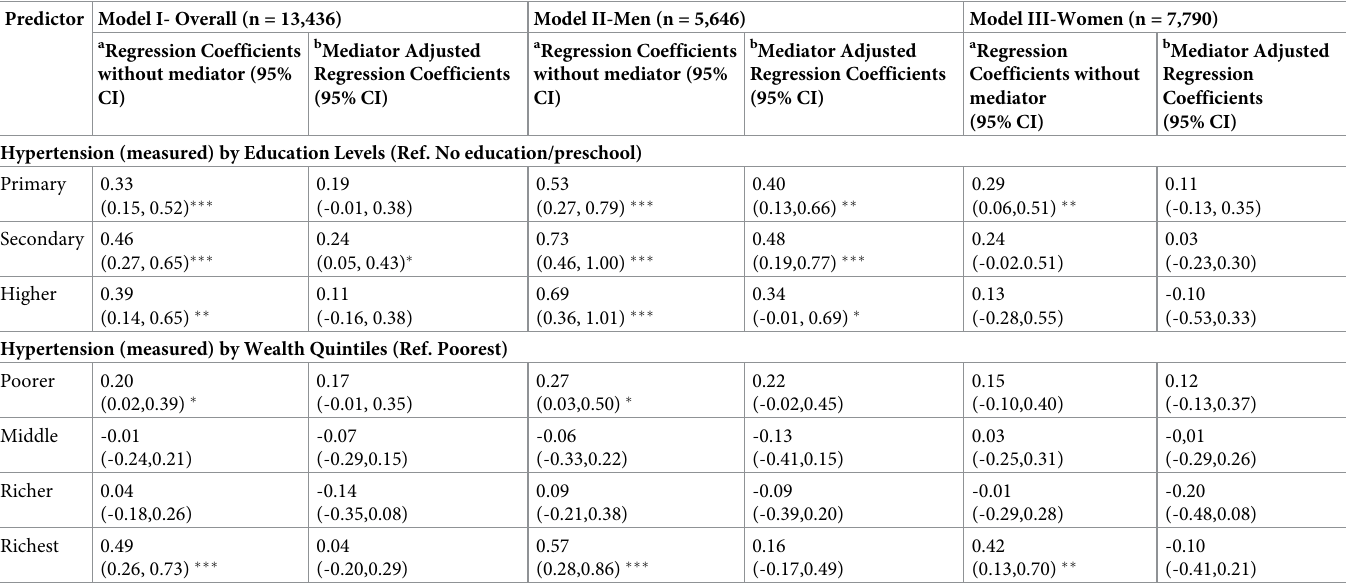
aCoefficients adjusted for age, sex, marital status, urbanity, and second-hand smoking; bCoefficients further adjusted for mediator-BMI. Regression coefficients; 95% confidence intervals in brackets